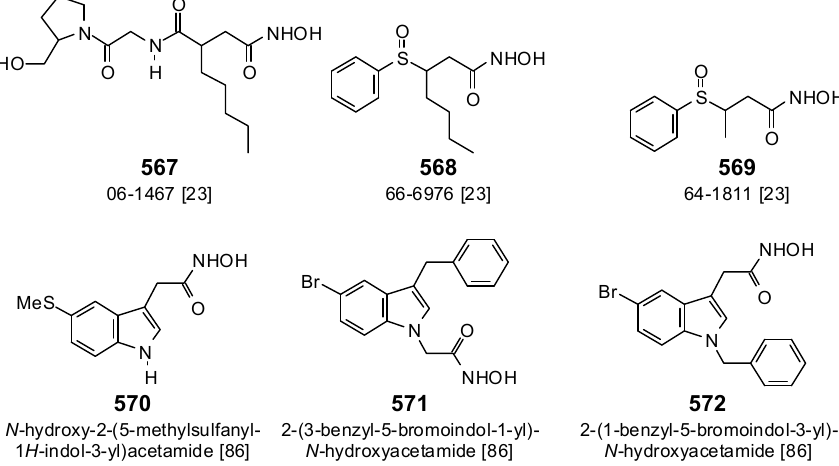
Figure 25. Structures of the synthetic bacterial peptide deformylase inhibitors.